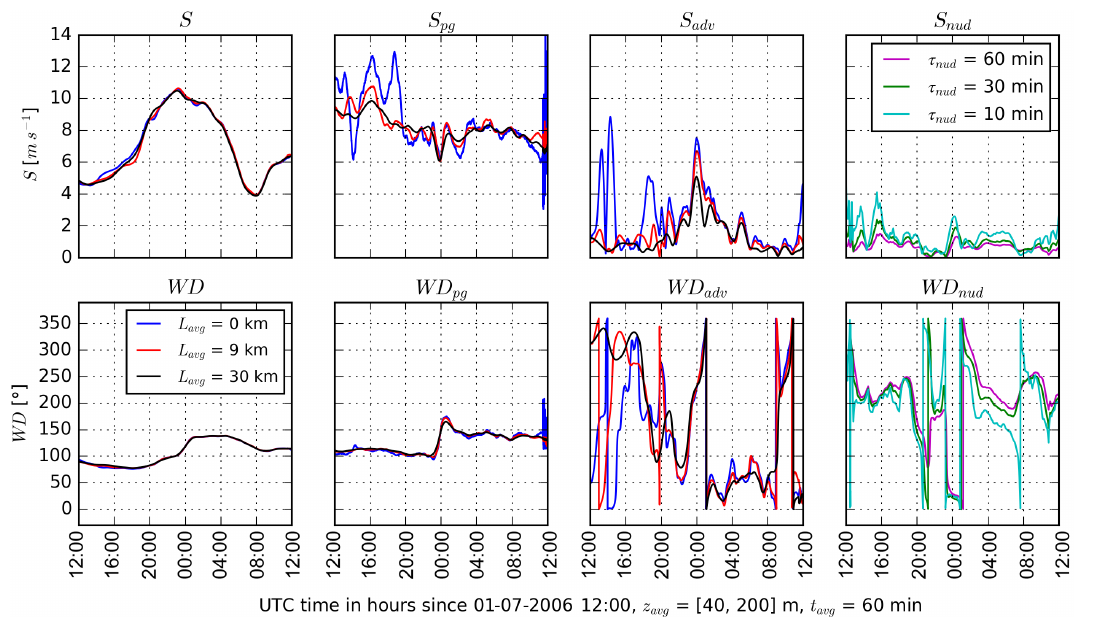
Figure 8. Magnitude S and direction WD of the wind vector, pressure gradient, advective and nudging forcing vertically averaged over a rotor span between 40 and 200m. Sensitivities to spatial averaging L avg and nudging timescale τ nud